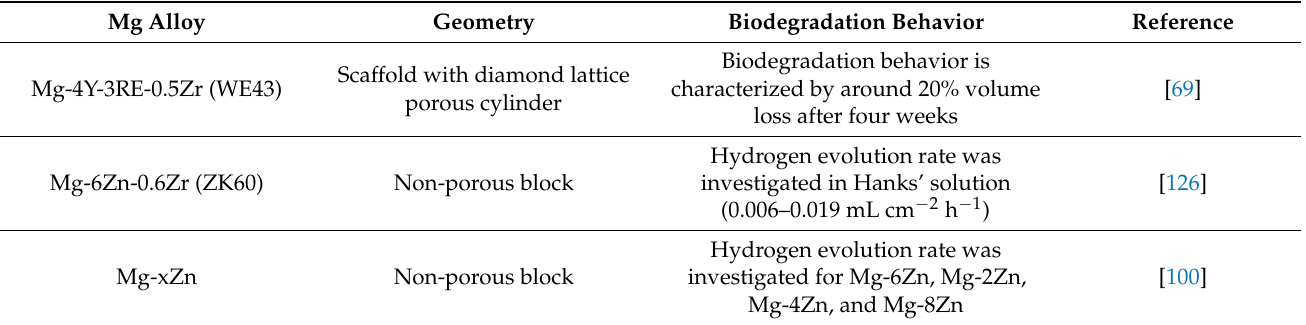
Table 4. Biodegradation property of AM Mg-based